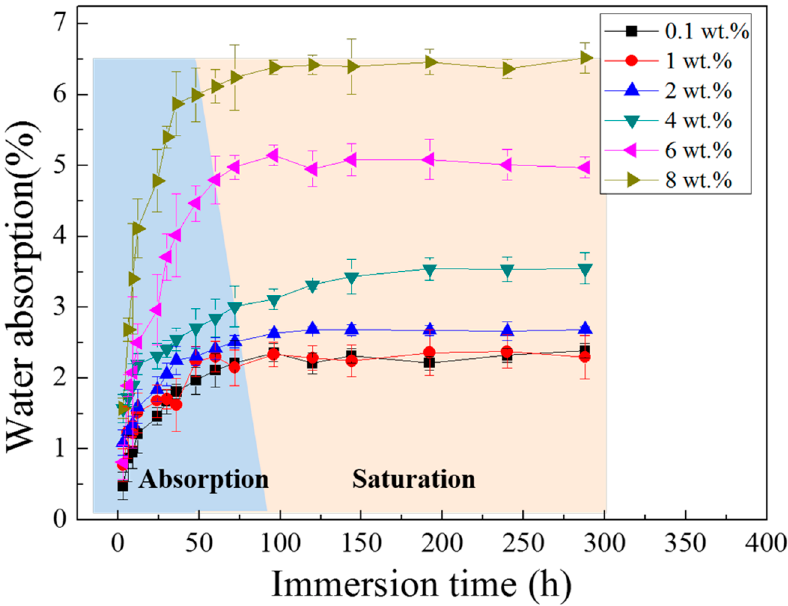
Figure 6. Water absorption curves for the free film samples in 3.5% NaCl solution for different immersion period.